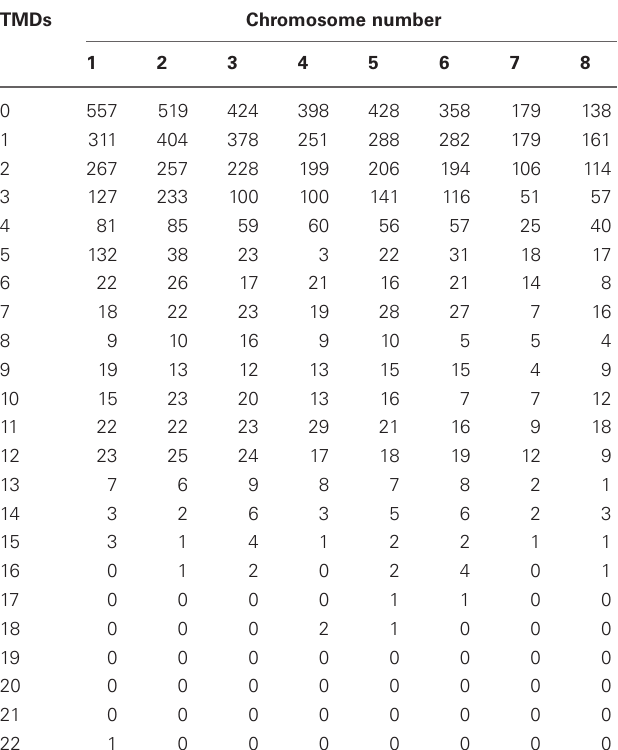
Table 1 | Numbers of predicted A. fumigatus TMD proteins, by